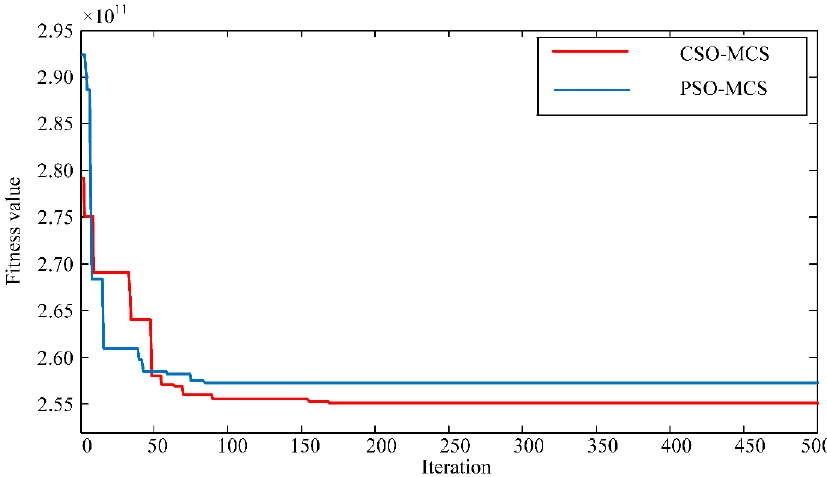
Figure 5. Convergence characteristics of CSO-MCS and PSO-MCS (Case 2). Table 5. Results obtained by CSO-MCS and PSO-MCS (30 runs for Case 2). Evaluation